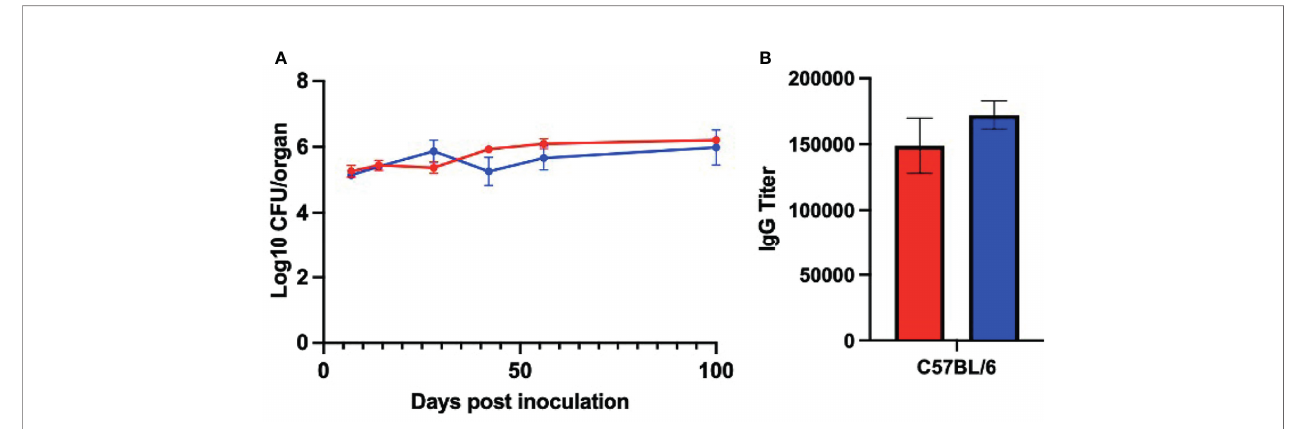
FIGURE 6 | PsxA does not affect persistence in Rag-/- mice or serum antibody production. (A) Log10 of CFU of WT B. pseudohinzii (red) or B. pseudohinzii D psxA (blue) recovered from the middle ears of Rag1 -/- mice on days 7, 14, 28, 42, 56, and 100 post inoculation (n=4 per strain per timepoint). (B) Serum from C57BL/6 mice 56 days after inoculation with B. pseudohinzii or B pseudohinzii D psxA was analyzed by ELISA for anti- B. pseudohinzii titers (results are the average of two independent assays). Error bars show the standard error of the mean. Statistical signi fi cance was calculated via Two-way